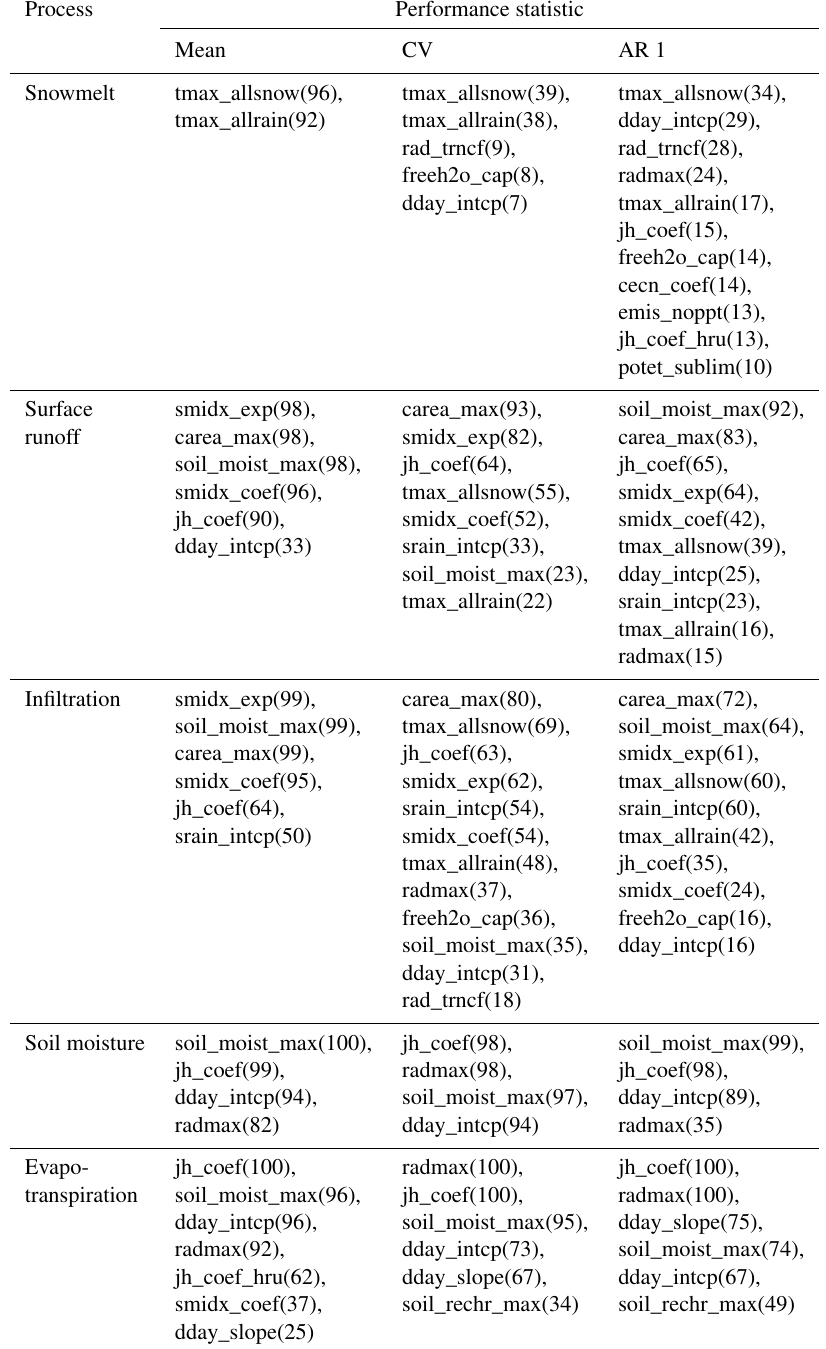
Table 2. Ordered list of most sensitive Precipitation–Runoff Modeling System calibration parameters by process and performance statistic. The parameters listed in each cell of the table are those that are required to account for 90% of the cumulative sensitivity across all hydrologic response units (HRUs). The number in parentheses following the parameter name is the proportion of the CONUS HRUs, in percent, in which that parameter is part of the set that accounts for 90% of the cumulated sensitivity on an HRU-by-HRU basis. These parameters are described in Table